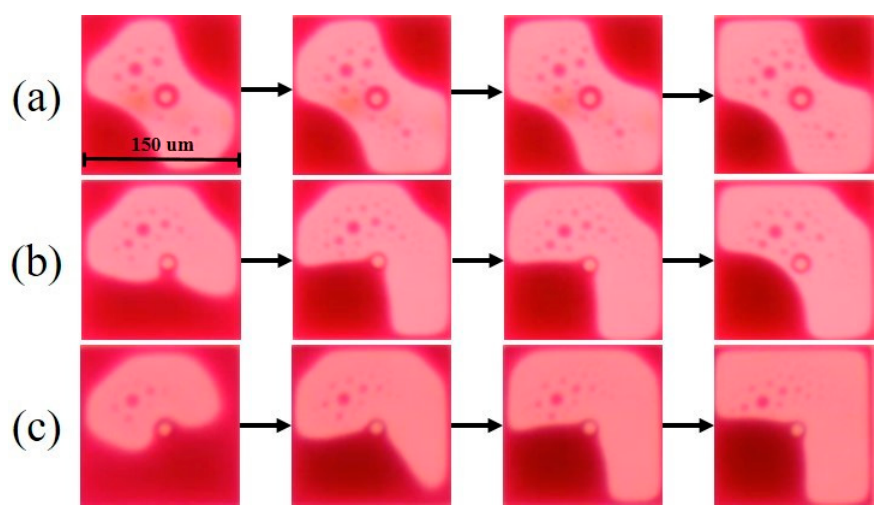
Figure 9. The driving process of different driving waveforms in a single EWD pixel. ( a ) Exponential function driving waveform. ( b ) Linear function driving waveform. ( c ) Proposed driving waveform. The splitting pieces of oil film driven by the proposed driving waveform was minimum; its aperture ratio was 66.8%. On the contrary, the splitting pieces of oil film driven by the exponential function driving waveform was maximum; its aperture ratio was 62.33%.